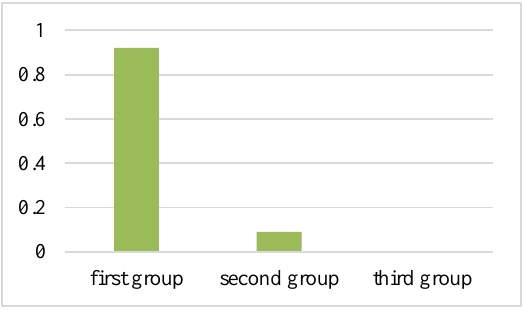
Figure 5. The hate mode in autistic children